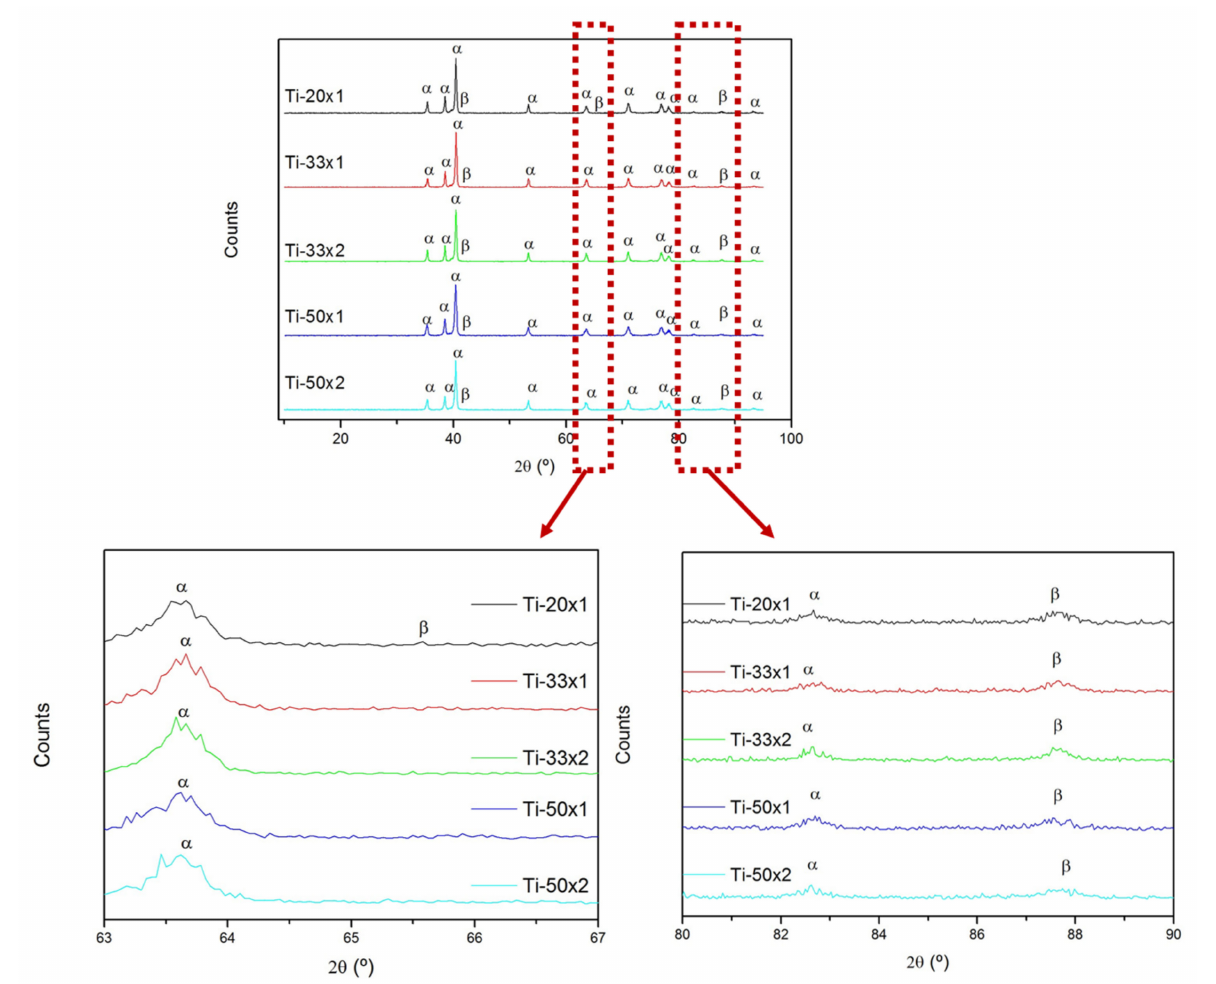
Figure 7. XRD spectra of all samples with details of the peak at 63.5 ◦ and